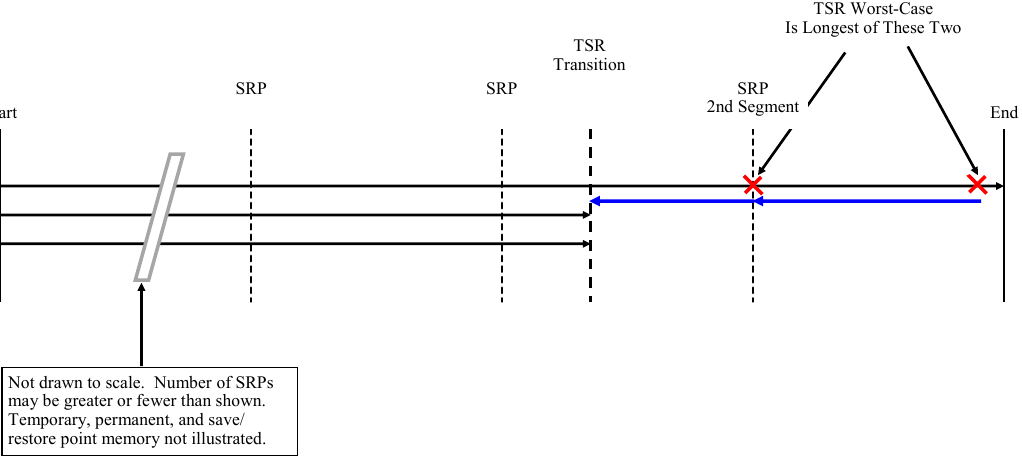
Figure A19. AHR MIPS TSR Worst-Case Early Error Timing Diagram